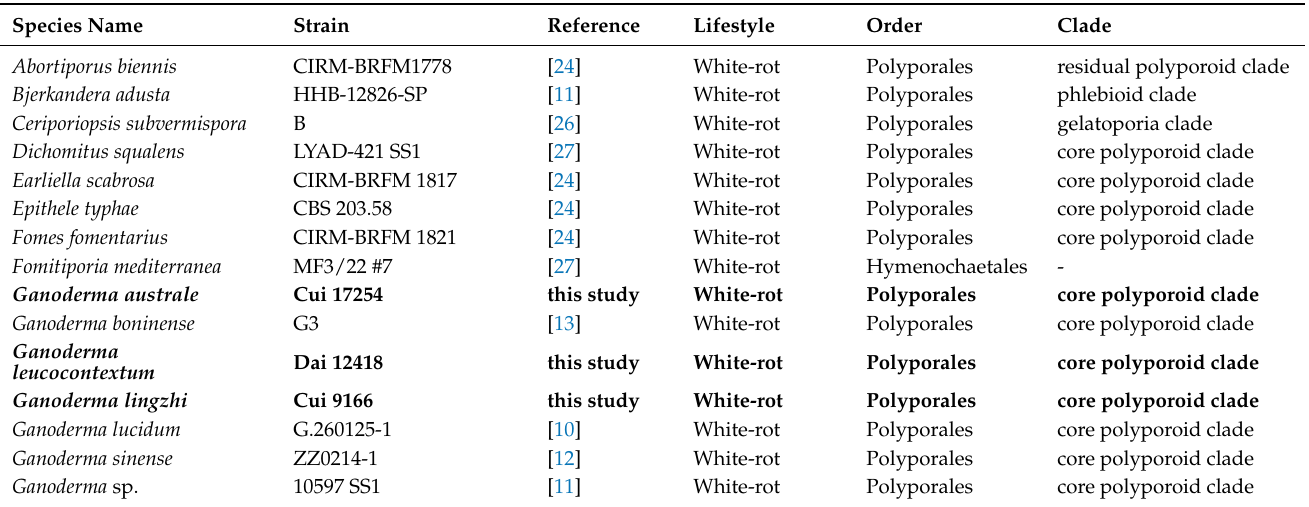
Table 1. List of the 58 genomes used for phylogenomic and comparative analyses. The new genomes are shown in